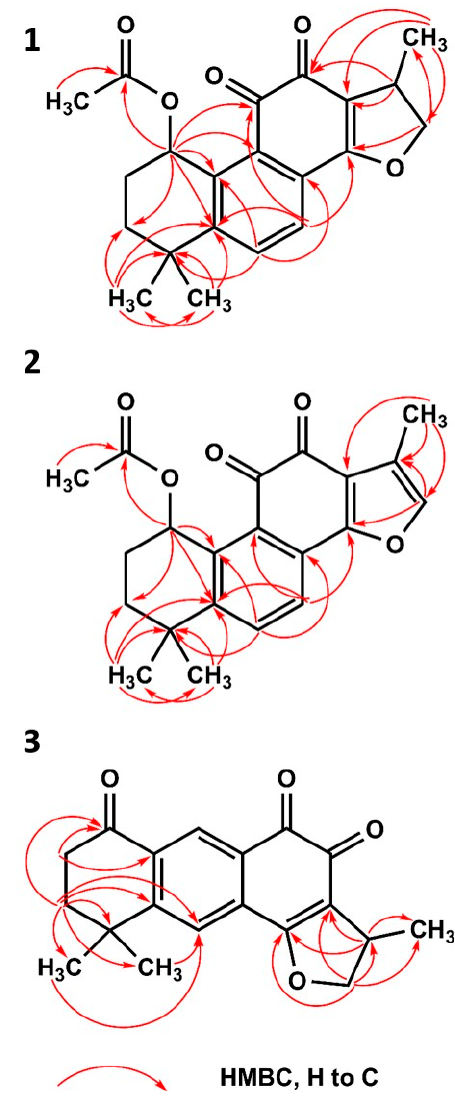
Figure 2. HMBC correlations of compounds 1–3.